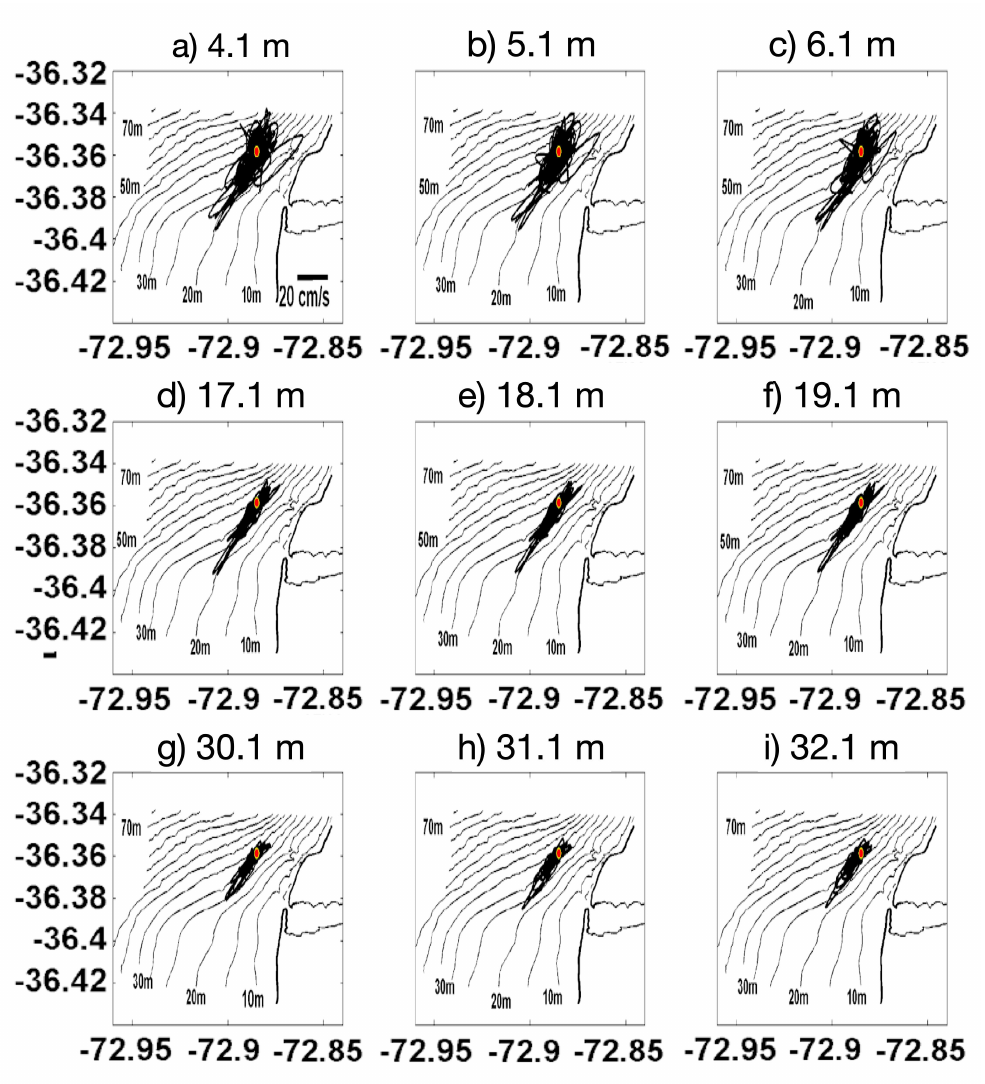
Figure 2. Scatterplots of synoptic currents (hodographs) from 4.1 m to 32.1 m depth ( a – i ) in the vicinity of the Itata River mouth. Isobaths are shown every 5